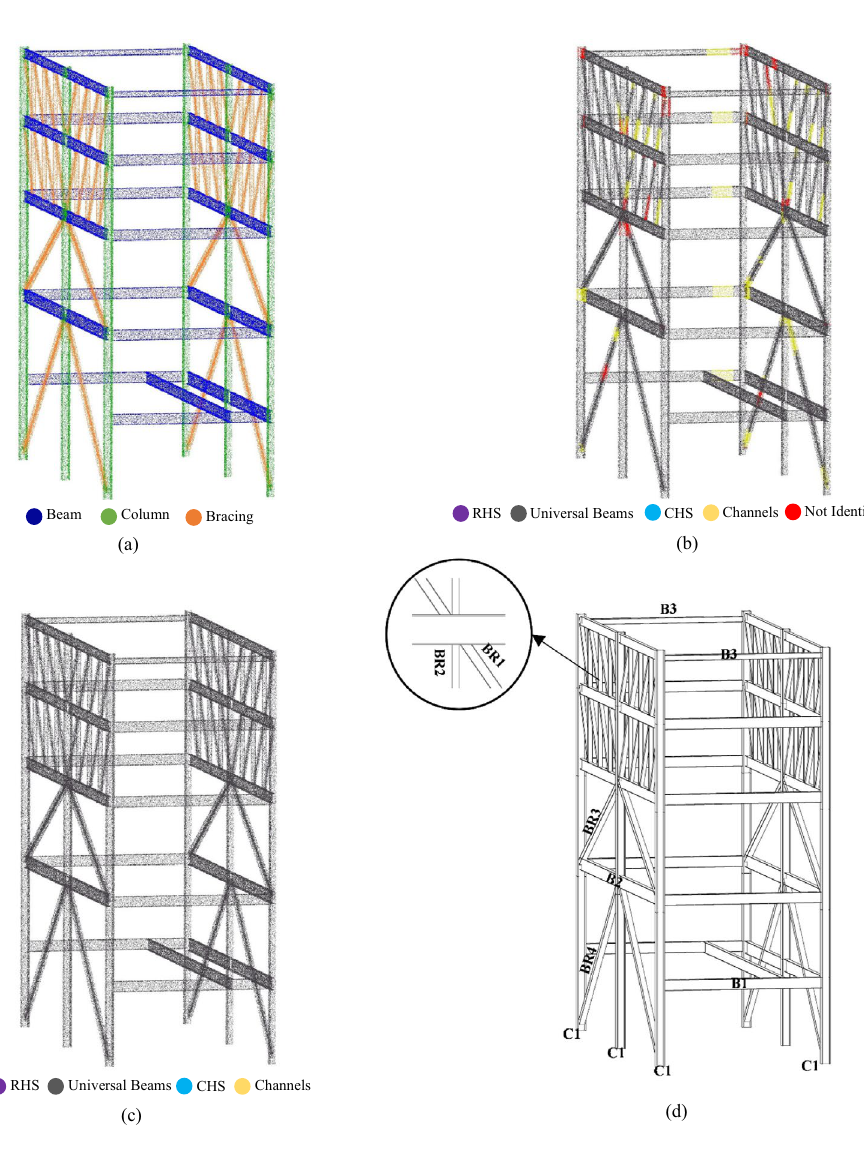
Figure 3. Applying the proposed method to the Woodside building case study: ( a ) Obtaining position information for detecting potential structural members. ( b ) Detection of section shapes. ( c ) Homogenization of structural shapes along the length of each member. ( d ) Automatically generated BIM model in Revit.